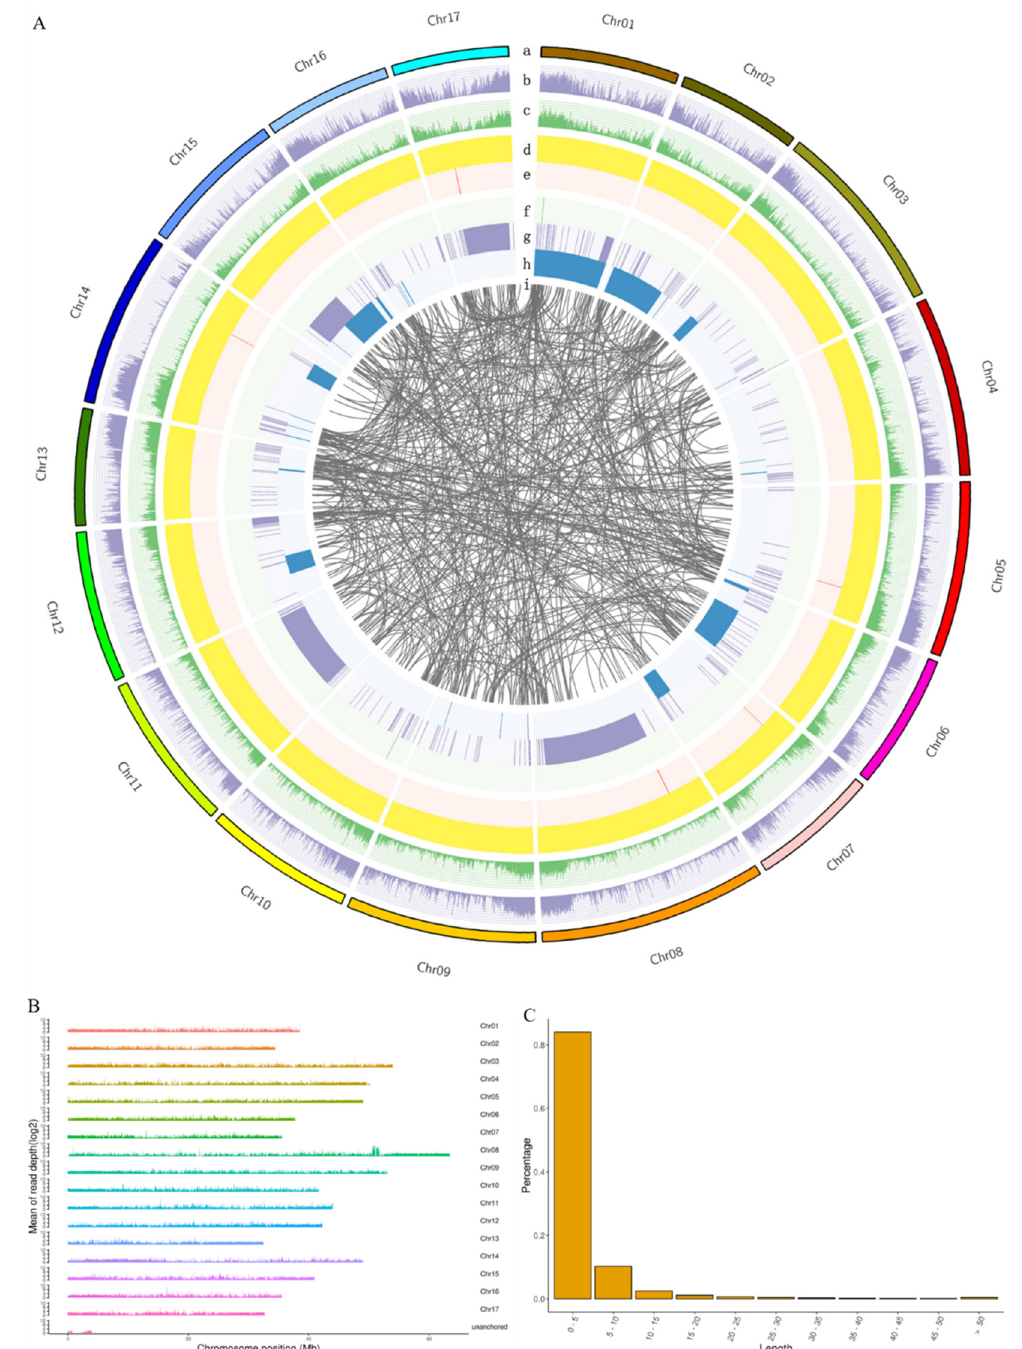
Figure 2. Resequencing of WT-W based on the WT-P genome sequence. ( A ) Genomic structure variation distribution between the two G. paniculata wild-type accessions. a: reference sequence. b: SNP density distribution. c: InDel distribution density. d: CNV duplication. e: CNV deletion. f: SV inser-